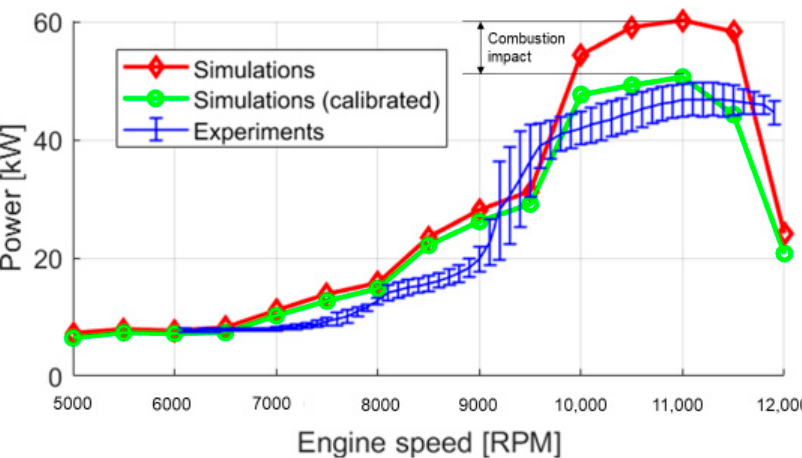
Figure 4. Uncalibrated and calibrated simulation model results and experimental